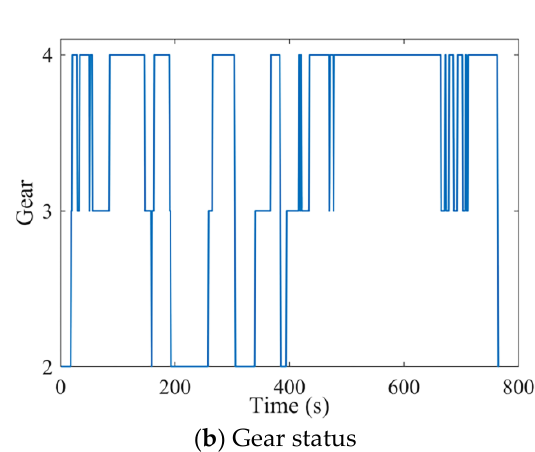
Figure 10. HWFET working condition.